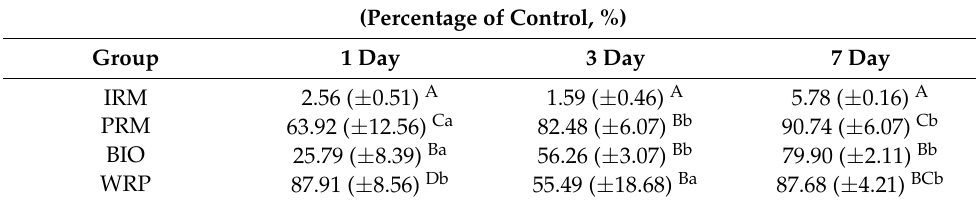
Table 2. Cell viability in 2D